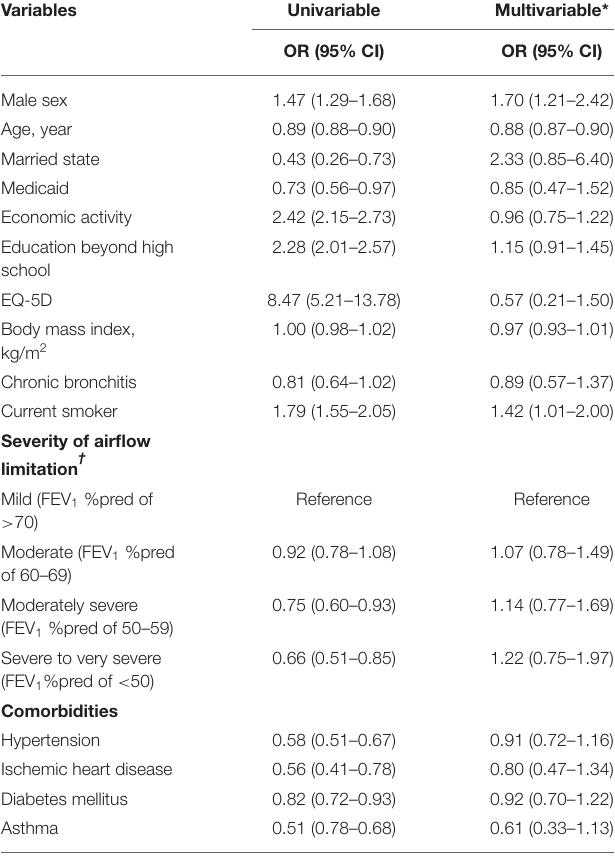
TABLE 2 | Factors associated with non-vaccination against influenza in participants with airflow